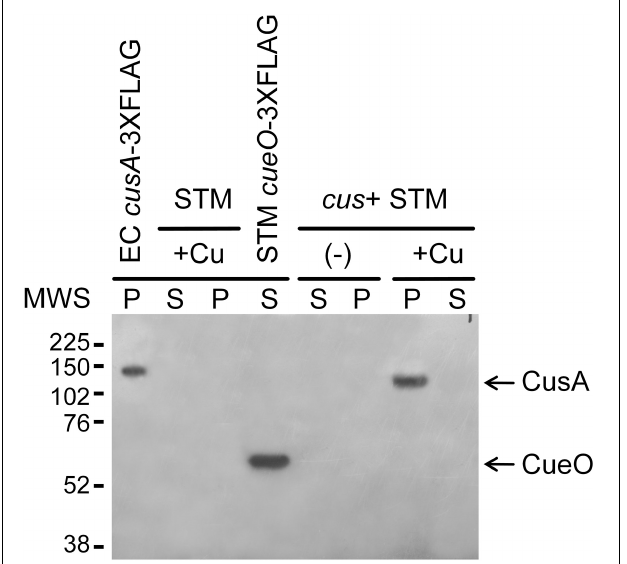
FIGURE 2 | The cus + Salmonella Typhimurium strain expresses CusA-3xFLAG in the presence of copper. Western blot analysis of soluble (S) and pellet cell fractions (P) of the transgenic cus + S . Typhimurium strain grown overnight in the presence ( + Cu) and absence ( − ) of 2 mM CuSO 4 . The pellet fraction of the W3110 cusS -Cm R cusA :3xFLAG - Km R Escherichia coli strain and the soluble fraction of the cueO :3xFLAG S . Typhimurium strain were used as positive controls, while the parental S . Typhimurium 14028s soluble and insoluble cell fractions were included as negative control. Anti-mouse FLAG monoclonal antibodies were used for the 3xFLAG immunodetection.